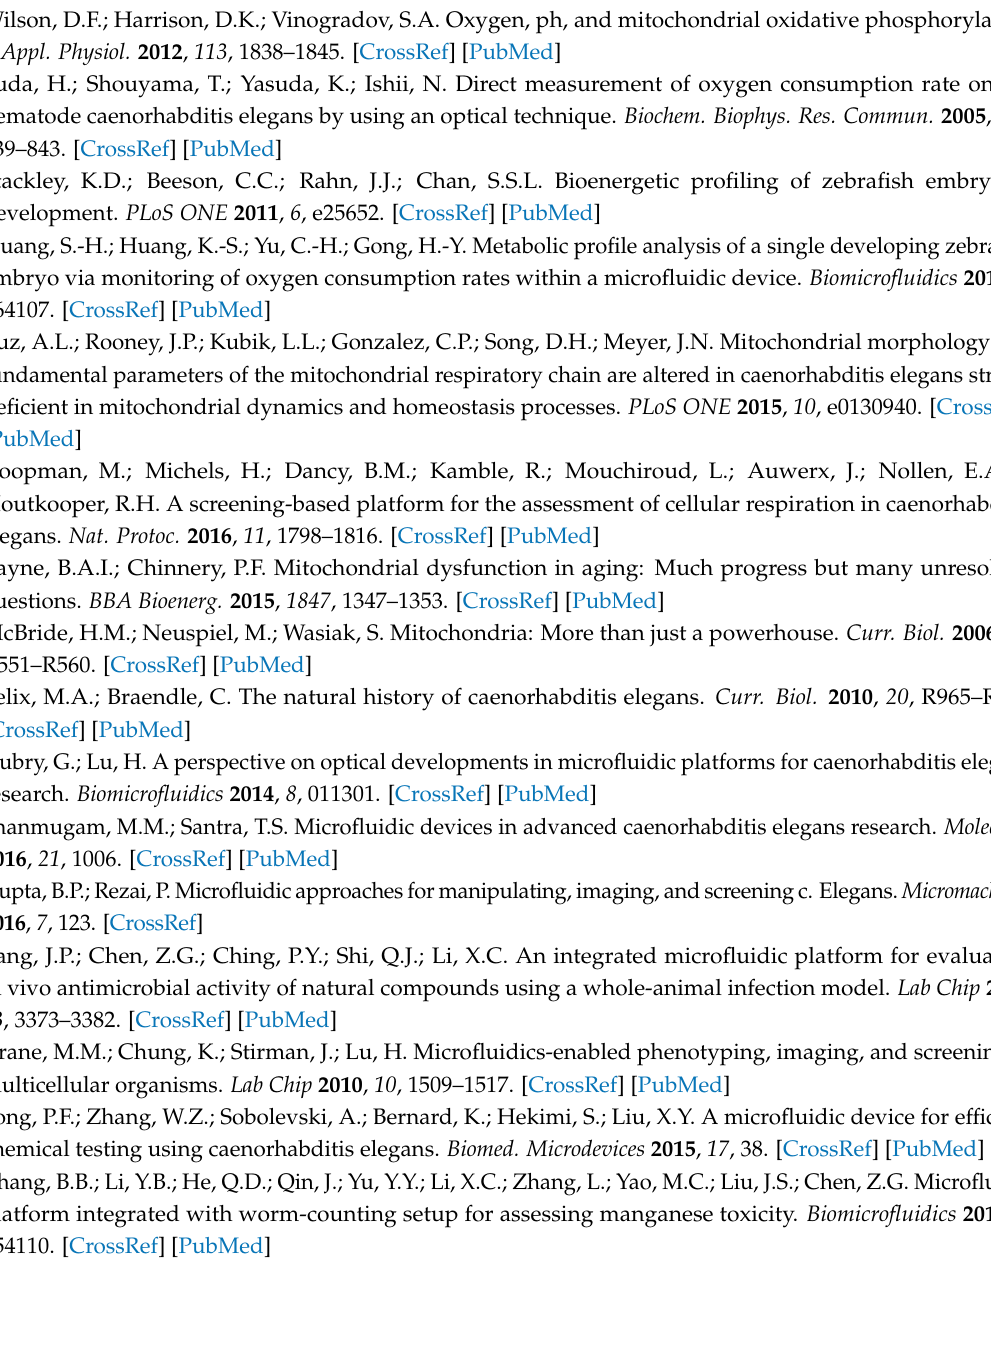
Figure S1: The variation of the phase shift ( θ ) and the corresponding Stern–Volmer calibration curve of the normalized lifetime ( τ 0 / τ ) as a function of the dissolved oxygen concentration, which was measured by a modulated excitation light at 5 kHz., Video S1: The assembly animation of all three layers and